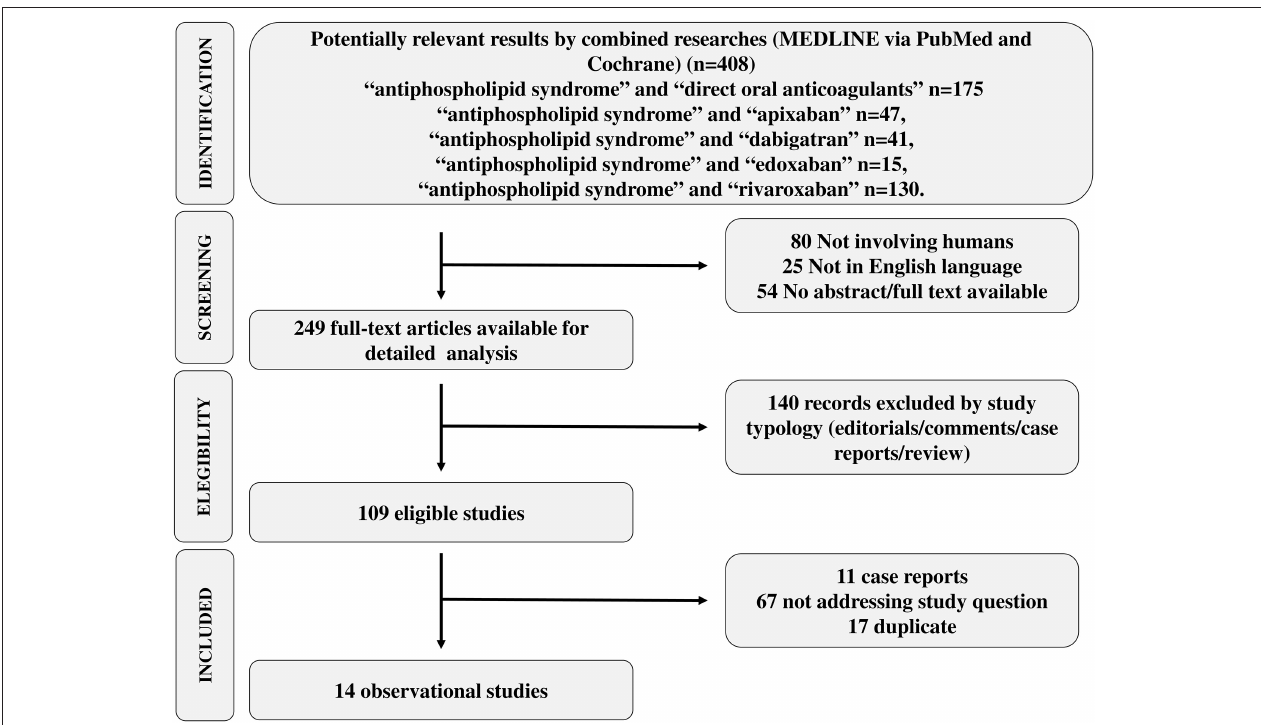
FIGURE 2 | PRISMA flow